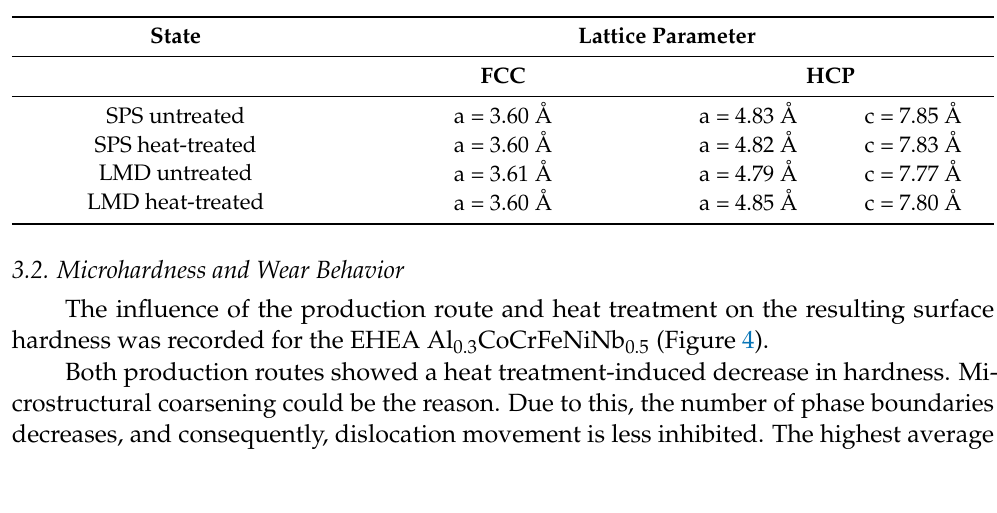
Table 4. Lattice parameters of the FCC and HCP phases determined by XRD for the bulk material and LMD coating of the EHEA Al 0.3 CoCrFeNiNb 0.5